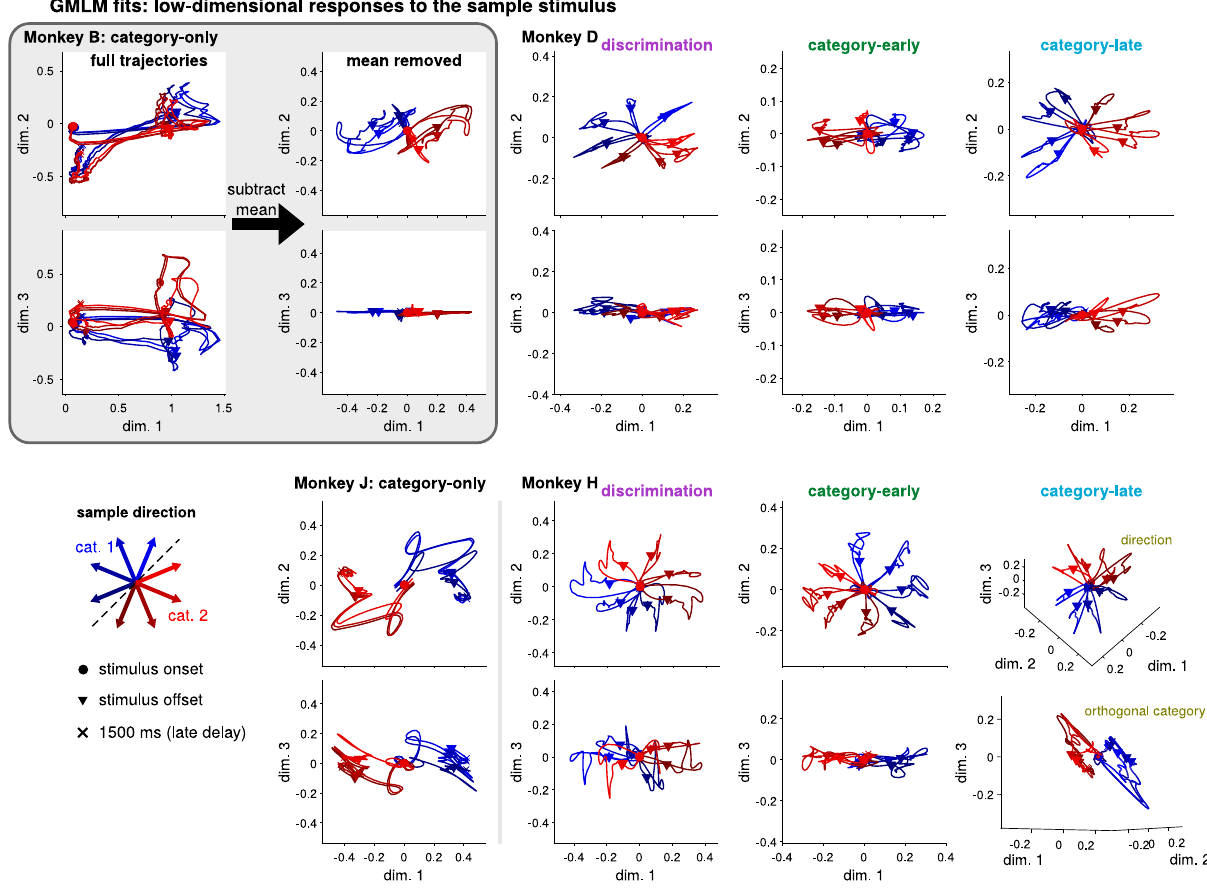
Fig. 5 | Low-dimensional representations of motion direction and category during the sample stimulus presentation and delay period. The top three dimensions of the GMLM ’ s sample stimulus encoding for each of the eight LIP populations with the mean response over all directions removed through the fi rst 1500ms of each trial were computed by taking the higher-order singular value decomposition of the stimulus kernel tensor in the GMLM to get the dimensions thatcapturedthemostvarianceinthetensor.TheinsetformonkeyBshowsthetop three dimensions including the mean (left) and the top three dimensions that